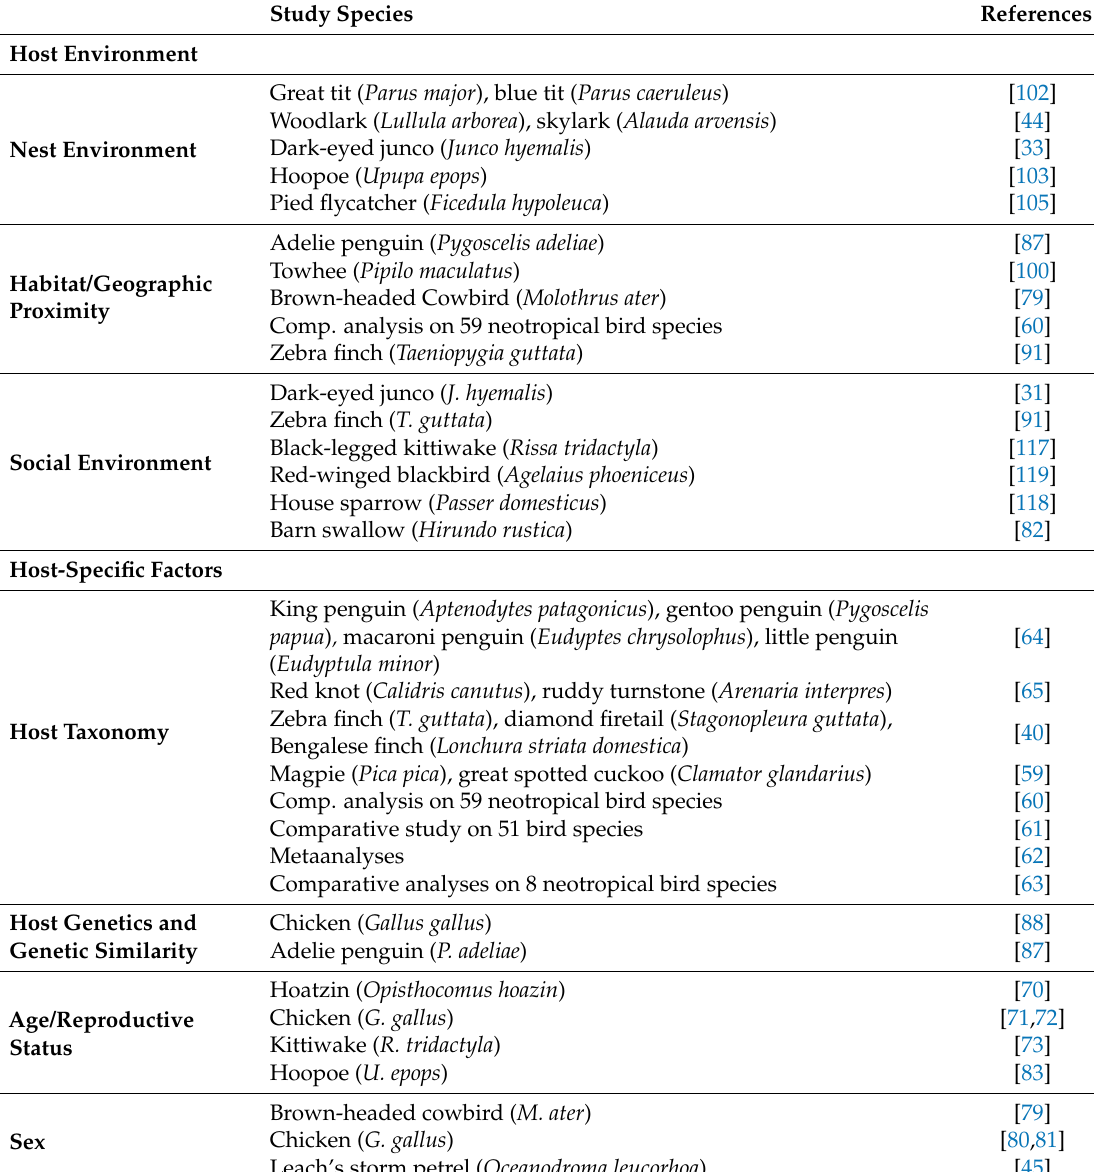
Table 1. Factors influencing microbiota in birds. Only studies confirming a positive link are included. Study